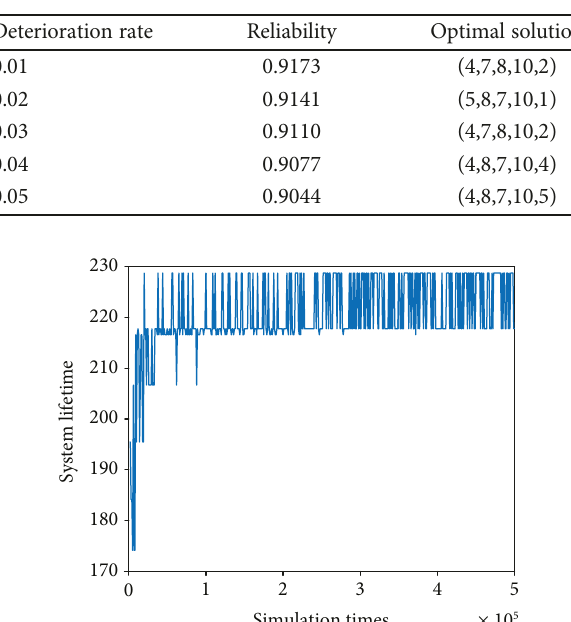
Table 4: Optimal solutions for di ff erent deterioration rates in the UMOM.